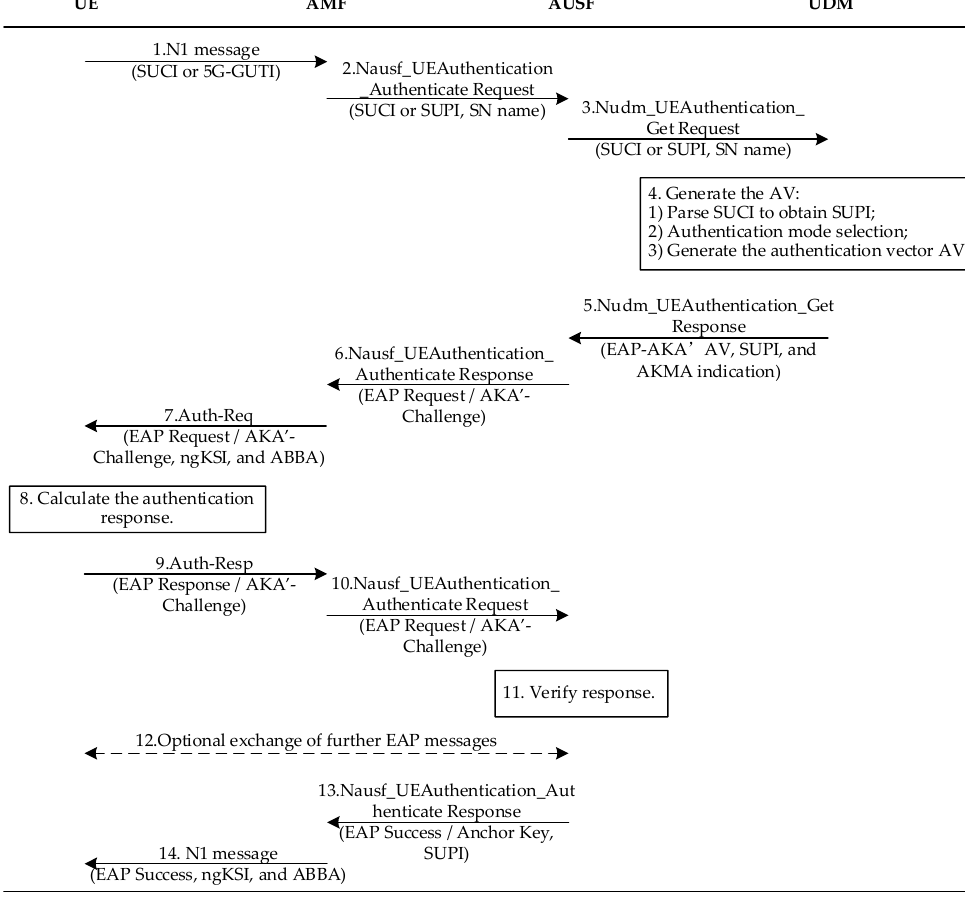
Figure 2. UE Authentication procedure [21]. Table 1. Some Abbreviations in